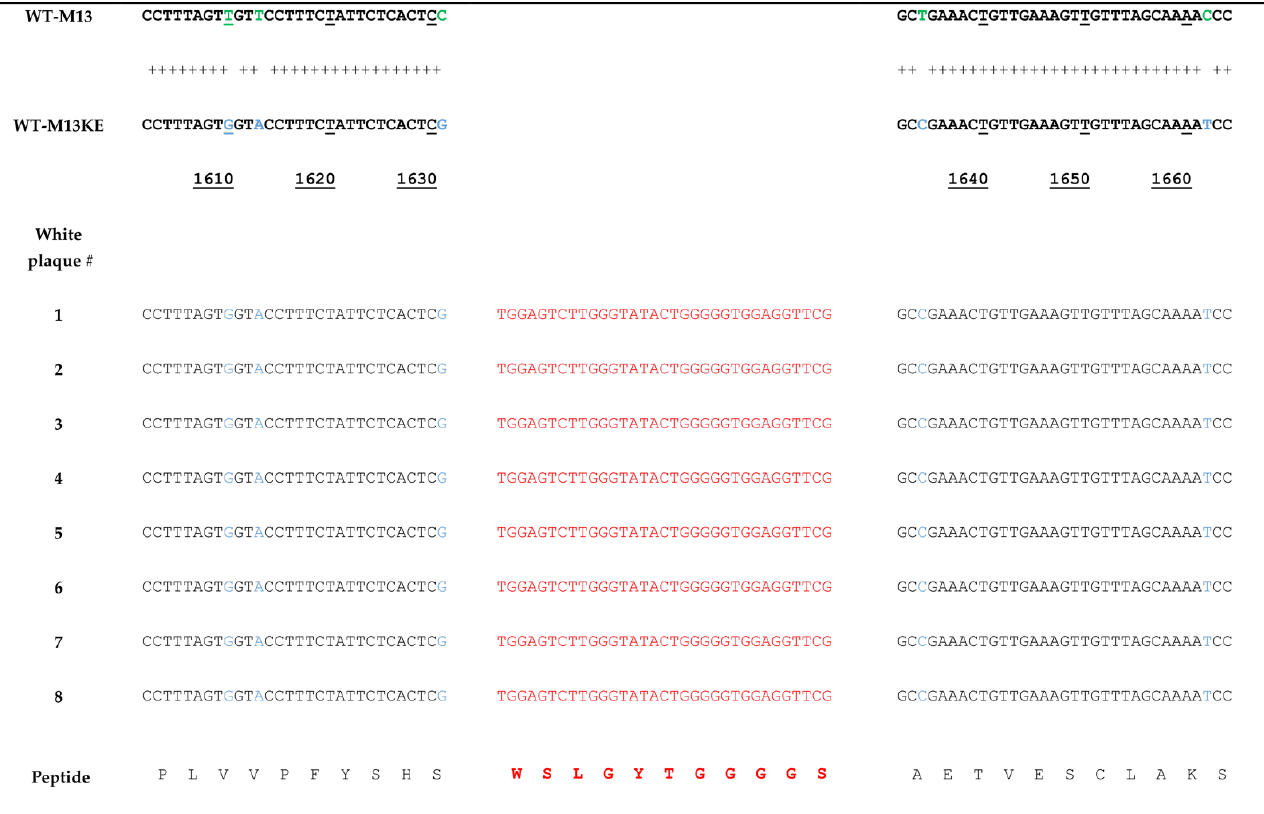
Figure 2. DNA sequence alignment between a fraction of the genomes of WT-M13 (at the top), WT-M13KE (in the middle) and eight isolated white plaques (at the bottom). All eight clones show evidence of arising from the library as they contain nucleotides (marked in blue) that differentiate them from the corresponding nucleotides in WT-M13 (marked in green). Additionally, all the eight white clones express the peptide WSLGYTG and the linker GGGS (marked in red), which are not present in the genomes of both WT-M13 and WT-M13KE. The nucleotide numbers refer to WT-M13KE genome. Compared to WT-M13, the nucleotide numbers are lower by 1 in WT-M13KE due to the deletion of T at position 1565. The alignment analysis was performed in SnapGene software (from Insightful Science; available at